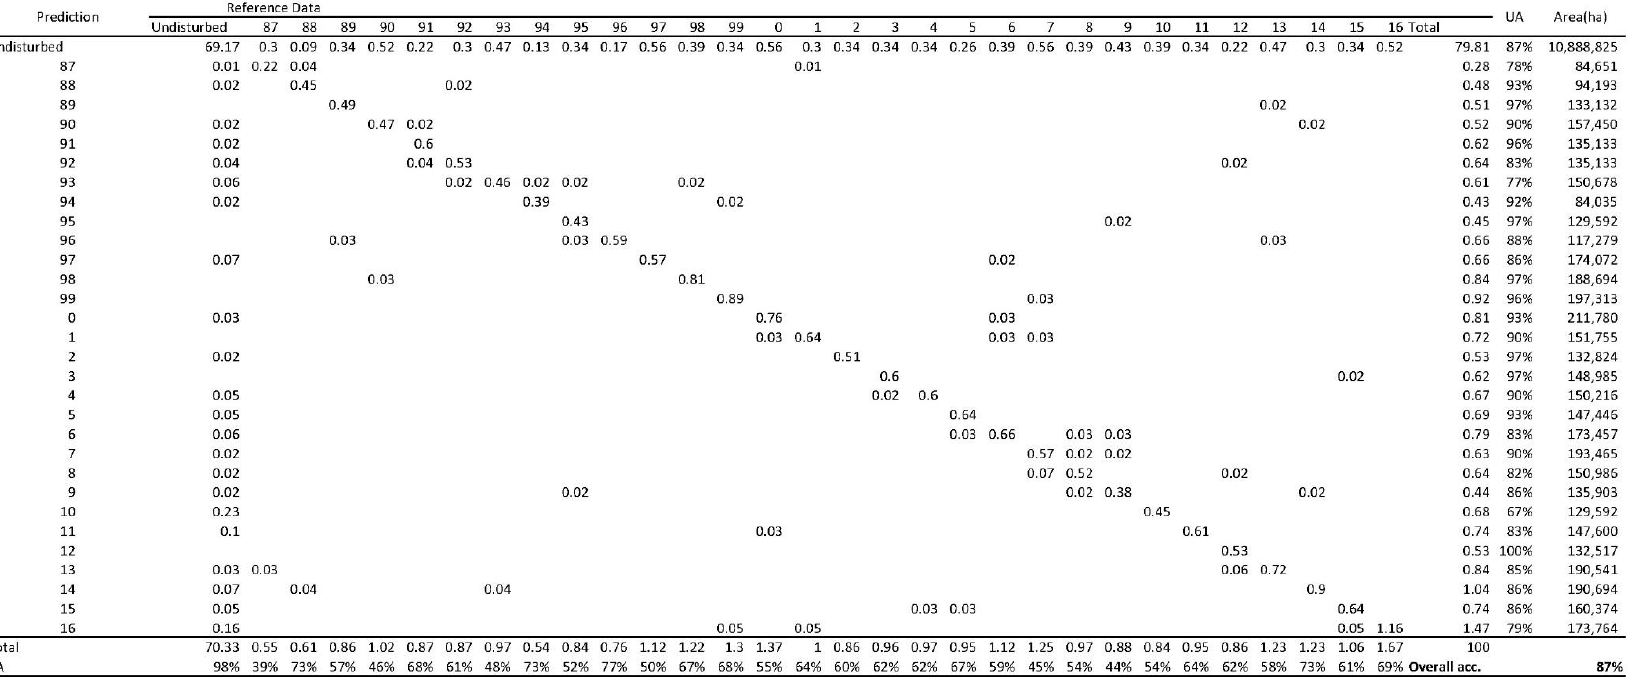
Figure A2. Area-adjusted confusion matrix. Reference data and prediction class values represent the last disturbance year (e.g., 89 = year 1989). The − 1 class represents the undisturbed class. UA = user’s accuracy. PA = producer’s accuracy.